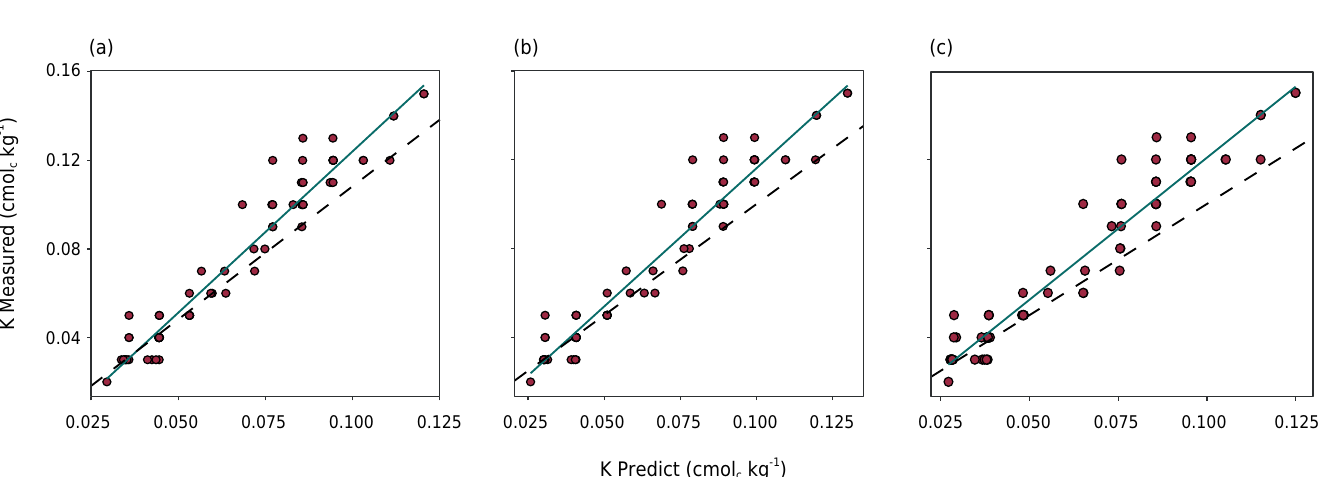
Figure 6. Scatterplots of K + of the measured vs predicted data, using PTF1 (a), PTF2 (b), and PTF3 (c). Validation samples from Latossolo Amarelo (Xanthic Oxisols), National Forest of Tapajós